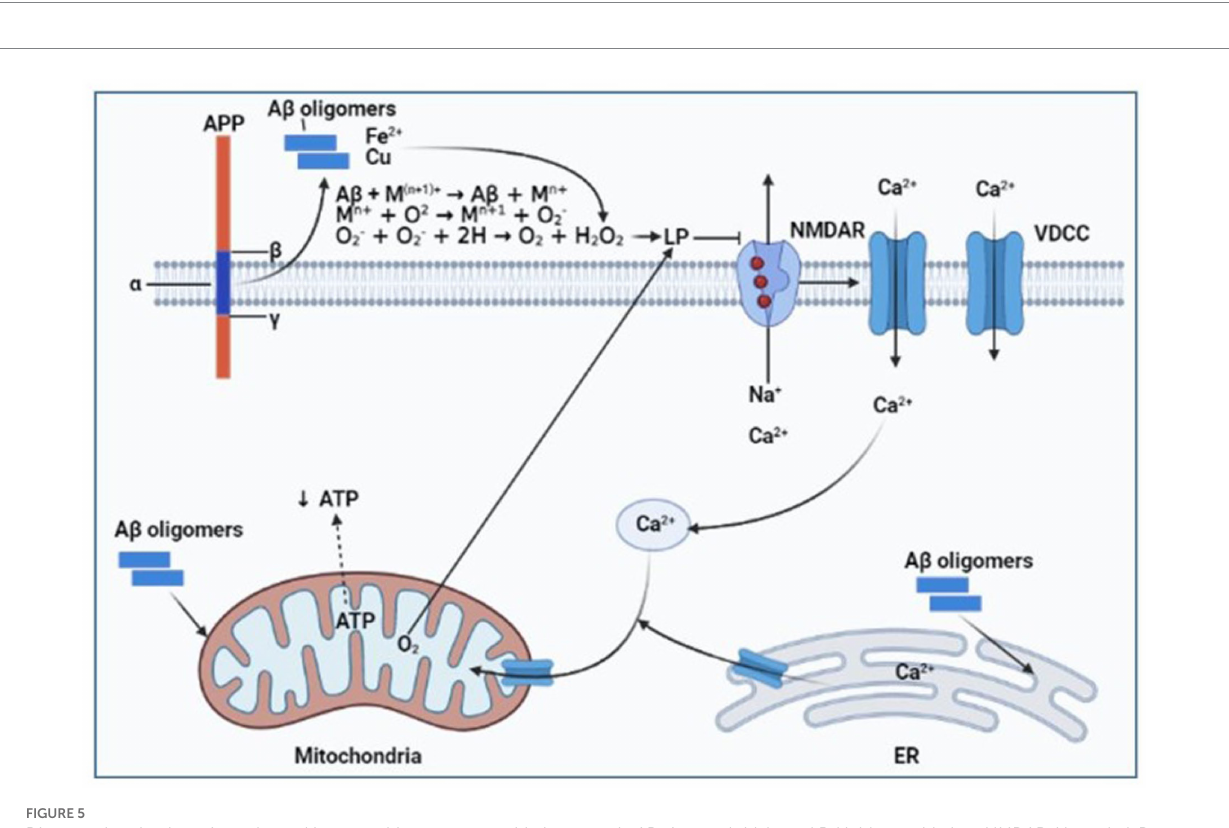
FIGURE 5 Diagram showing how A β and metal ions combine to cause oxidative stress in AD. A β , amyloid-beta; LP, Lipid peroxidation; NMDAR, N-methyl-D- aspartate receptor; VDCC, Voltage-dependent calcium channel; ER, endoplasmic reticulum; APP, Amyloid precursor protein; ATP, Adenosine triphosphate. Created with